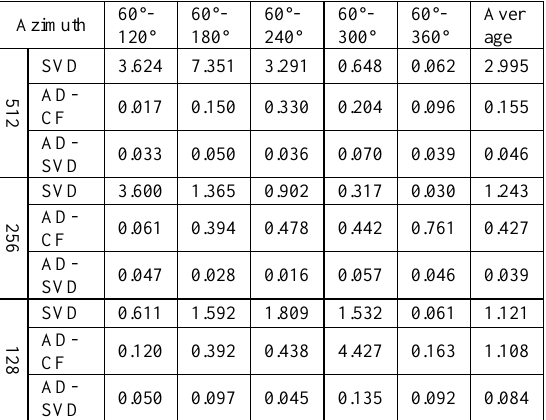
Table 1. Sub-pixel matching performance of three algorithms for different azimuth angles using window